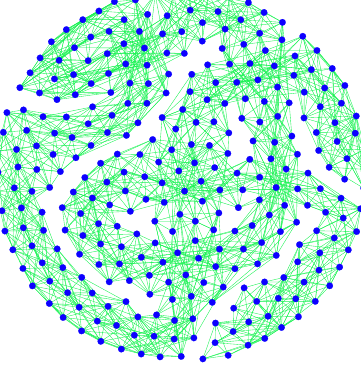
Figure 6. The subnet G 2 of G